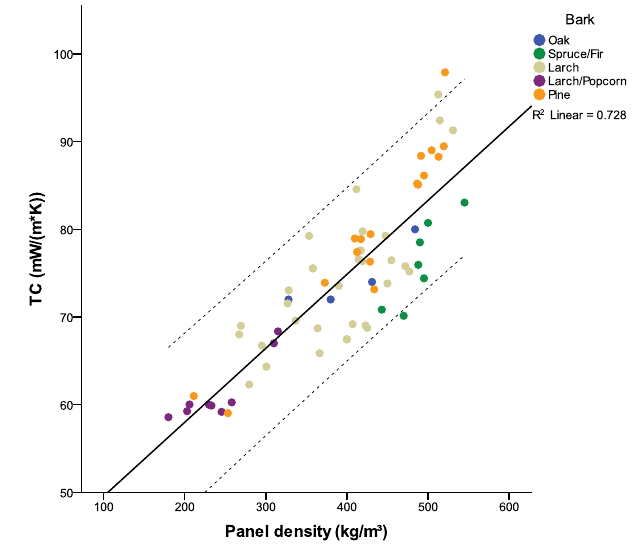
Figure 8. TC according to panel density with 95% confidence interval. Table 9. TC according to density class and bark type.